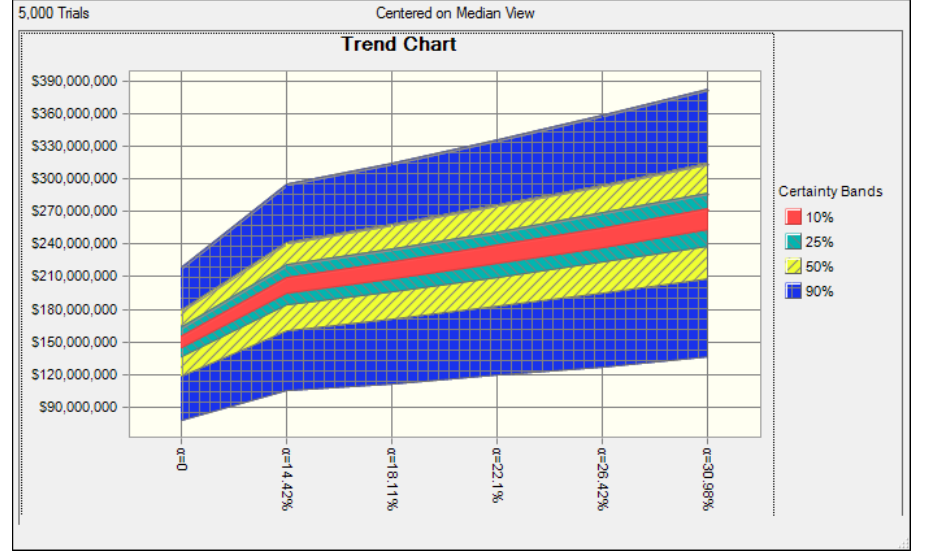
Figure 7. Diagram of sensitivity of fuel cost to peak-shaving ratio.